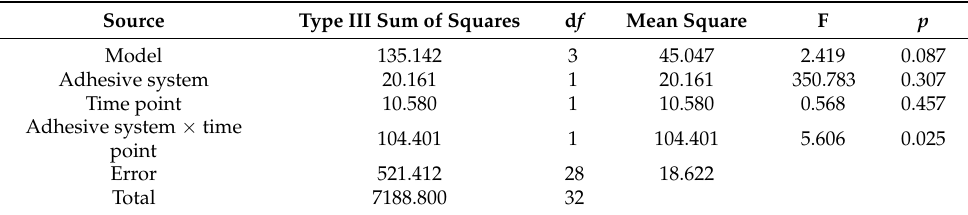
Figure 2. Bar chart comparing the experimental groups at different time points (immediate and after 3 months aging). No significant differences were found between the different experimental groups (ANOVA two-way, p = 0.087; n = 8). Error bars shown are standard error of the mean values (SE). Table 3. Two-way ANOVA results, considering the factors: experimental group and time point for the microtensile bond strength dependent variable.